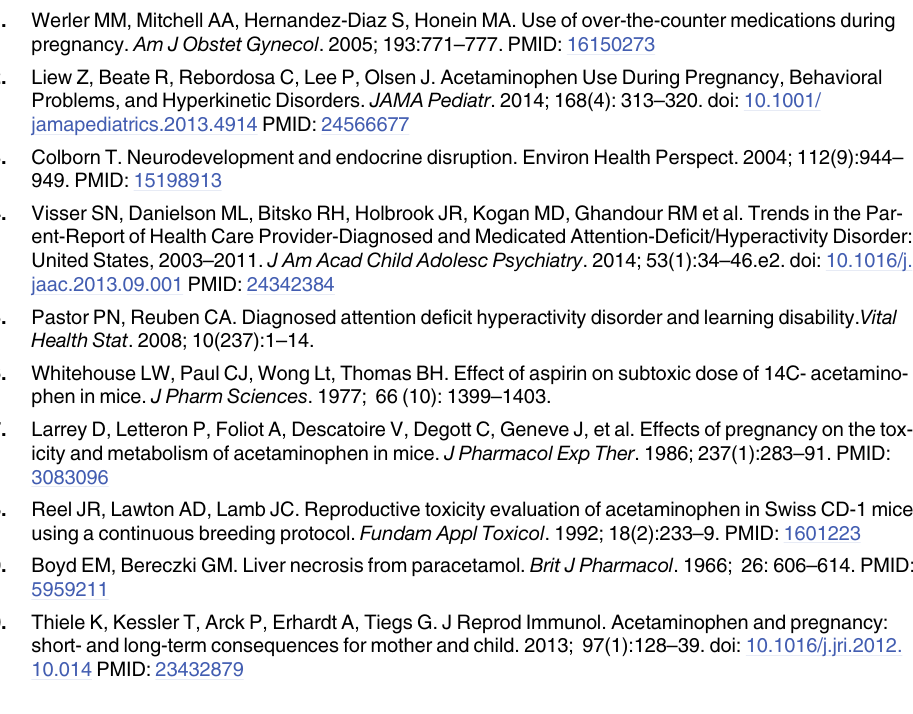
S1 Fig. Brain Volumes in postnatal day 30 offspring. Three-dimensional T2-weighted images of whole brain were obtained using a vertical bore 11.7 Tesla MRI scanner. Coronal and axial representative areas are illustrated. CC, Corpus Callosum. R, right; L,